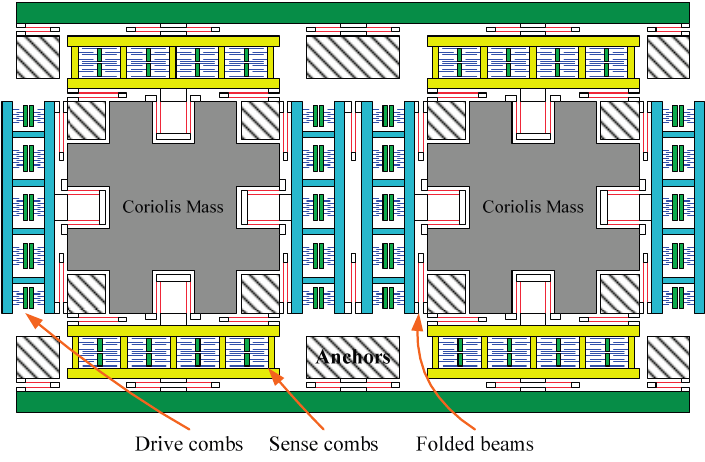
Figure 1. Simplified schematic of the tuning fork micro-gyroscope with mechanically coupled drive mode and sense